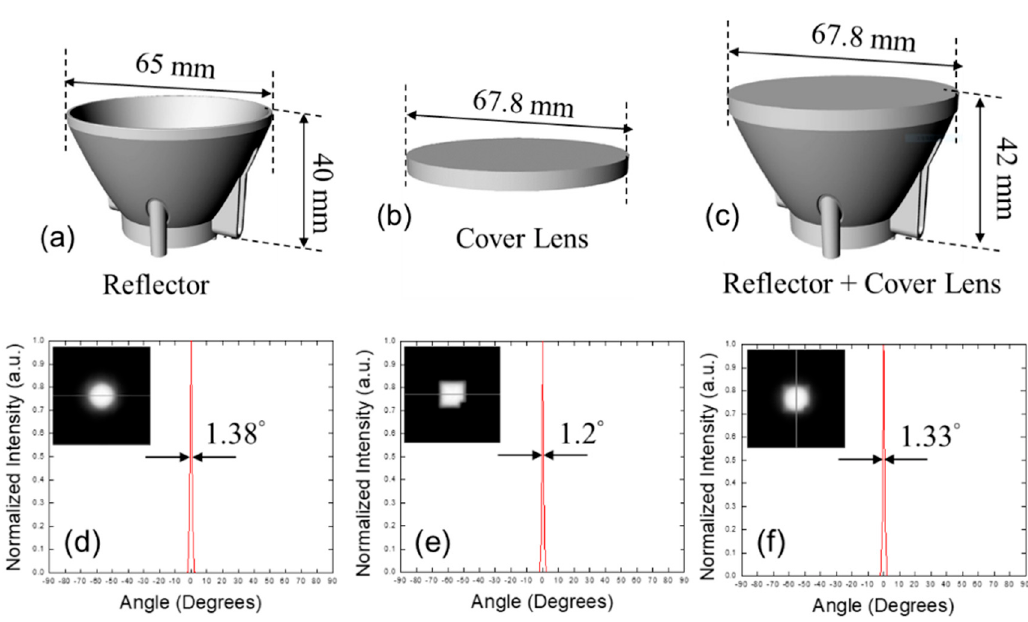
Figure 6. Structure of the ( a ) parabolic reflector, ( b ) cover lens, and ( c ) entire system. Simulated projection spot at a distance of 1 km and divergence angle of the light coming from the ( d ) parabolic reflector, ( e ) cover lens, and ( f ) entire system.